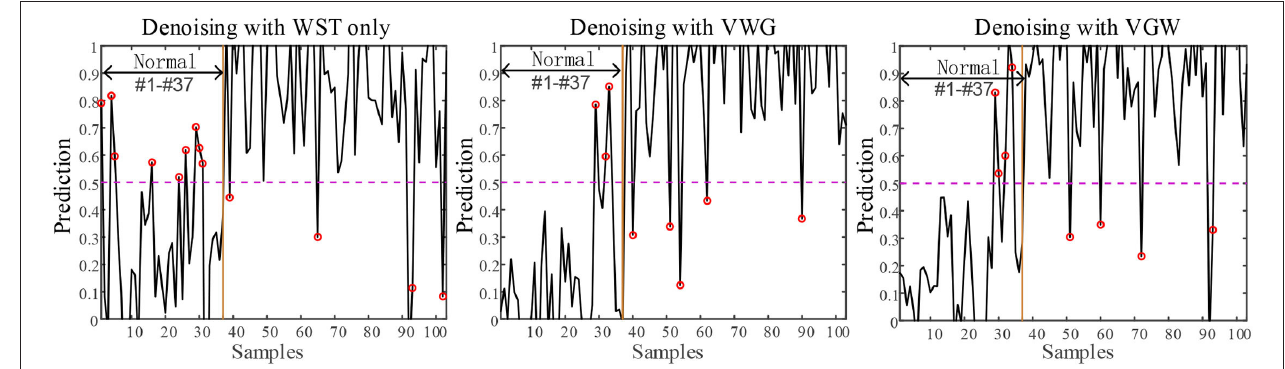
FIGURE 8 | The results of PCG classification with the WST only, VWG and VGW, respectively.